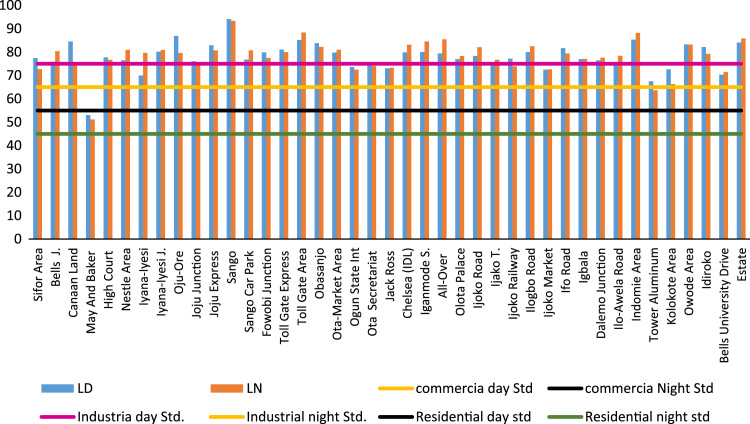
Variation of LD and LN values in the selected locations.